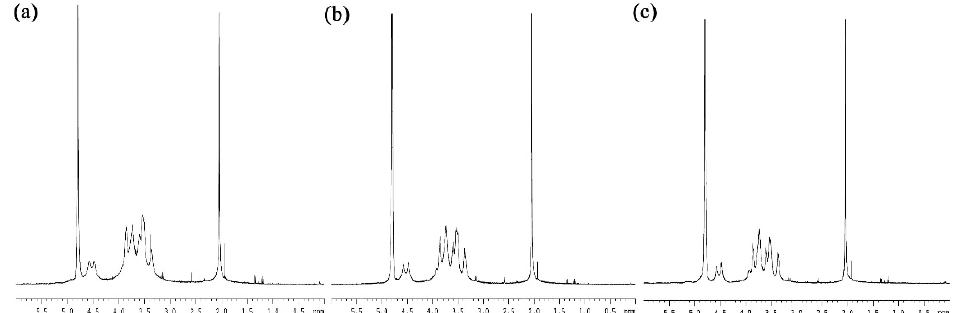
Figure 2. 1 H NMR spectra of H-HA/L-HA hybrids at mixing ratios of ( a ) 80:20, ( b ) 50:50 and ( c ) 20:80.